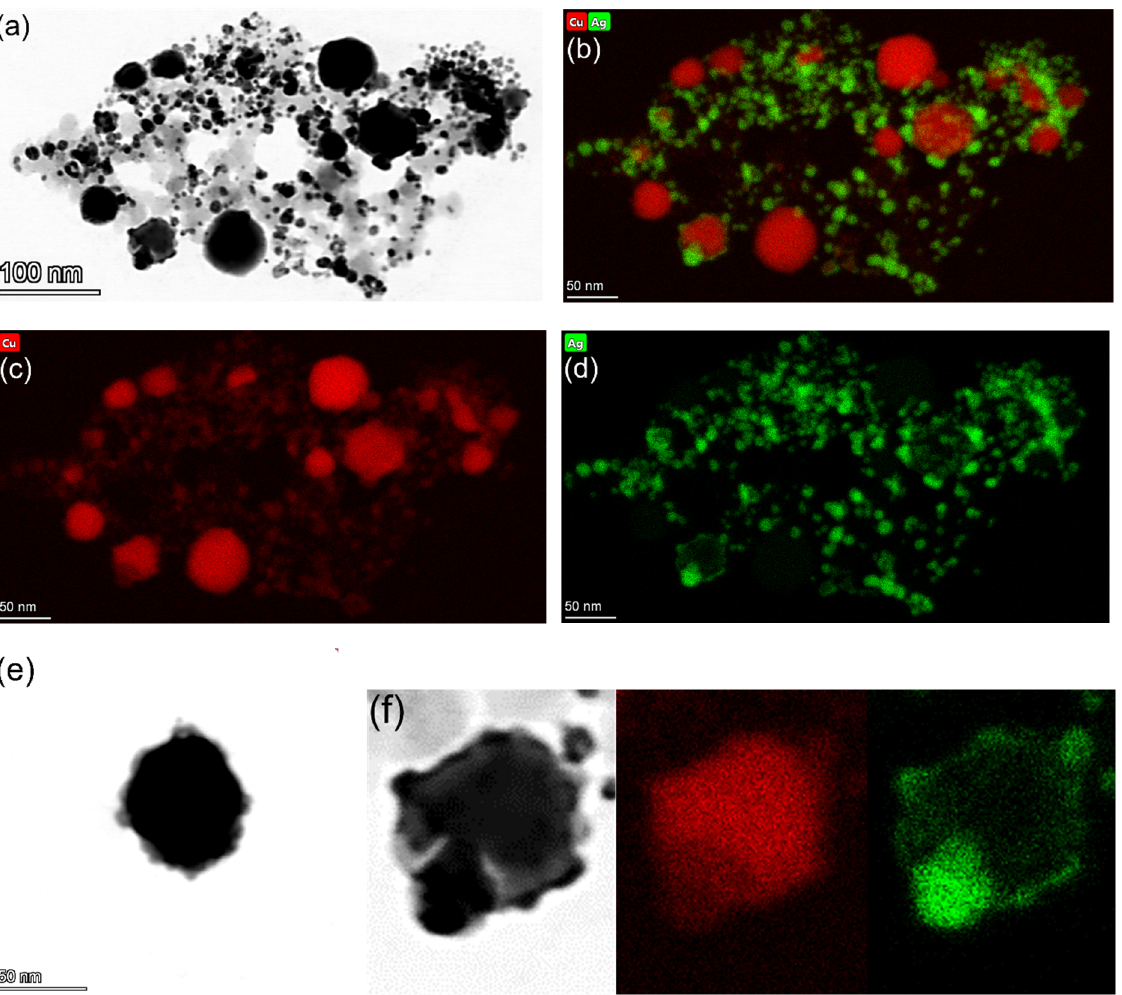
Figure 3. ( a ) TEM micrograph of the Cu–Ag NP catalyst; X-ray elemental mapping images of: ( b ) Cu & Ag; ( c ) Cu; and ( d ) Ag; ( e ) TEM image of a single Cu core –Ag shell NP; and ( f ) partial sections of TEM image, and Cu and Ag X-ray elemental mapping images showing the higher contrast of Ag on the smaller particles and higher contrast of Cu on the larger particles.